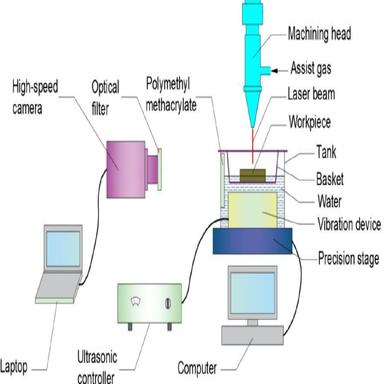
Schematic for a real-time observation system of the laser percussion drilling process assisted by water-based ultrasonic vibrations.